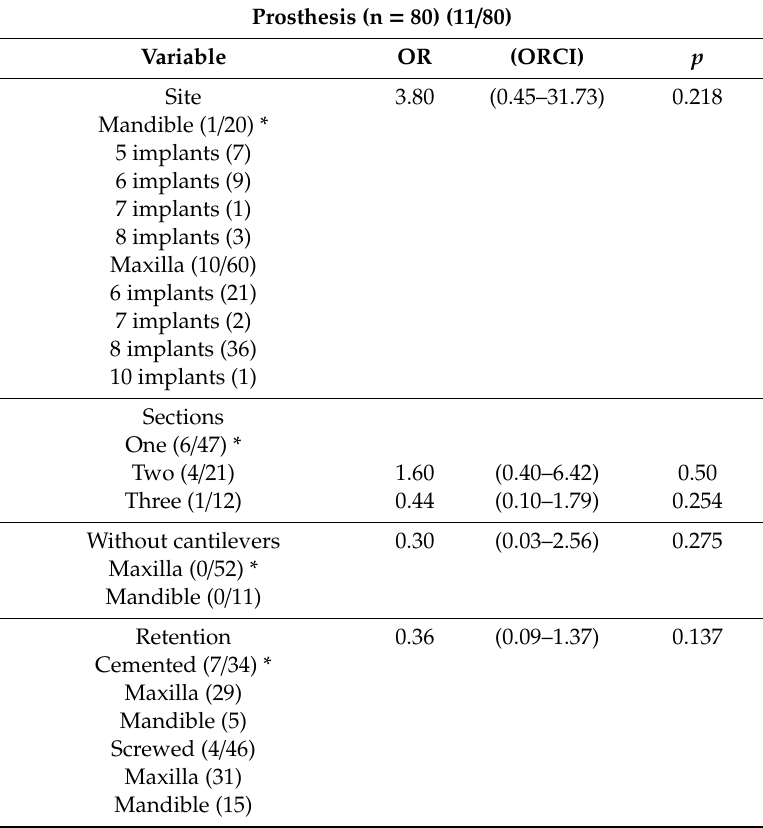
Table 5. Distribution of periimplantitis complications in the sample in relation to prosthesis based